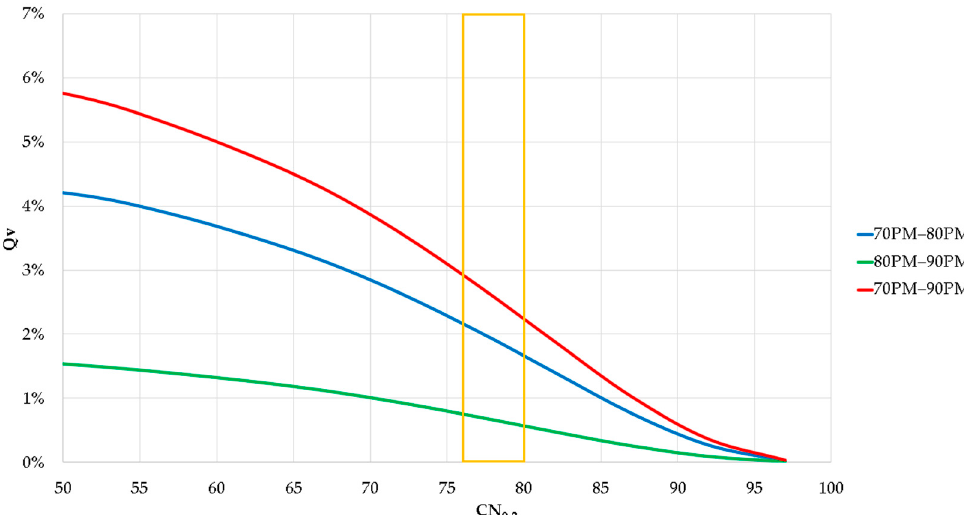
Figure 3. The decadal runoff trend for the interdecadal runoff difference between 70PM and 80PM, 80PM and 90PM, and 70PM and 90PM. The yellow box highlights the 99% BCa confidence interval of CN 0.2 for the Peninsular Malaysia dataset, in the range of 76–80.